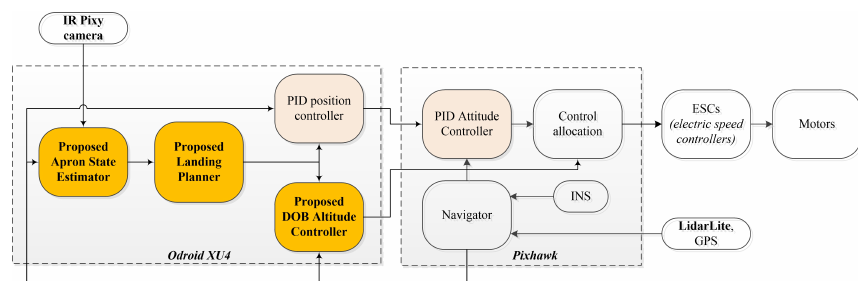
Figure 5. Block diagram of the system signal flow.